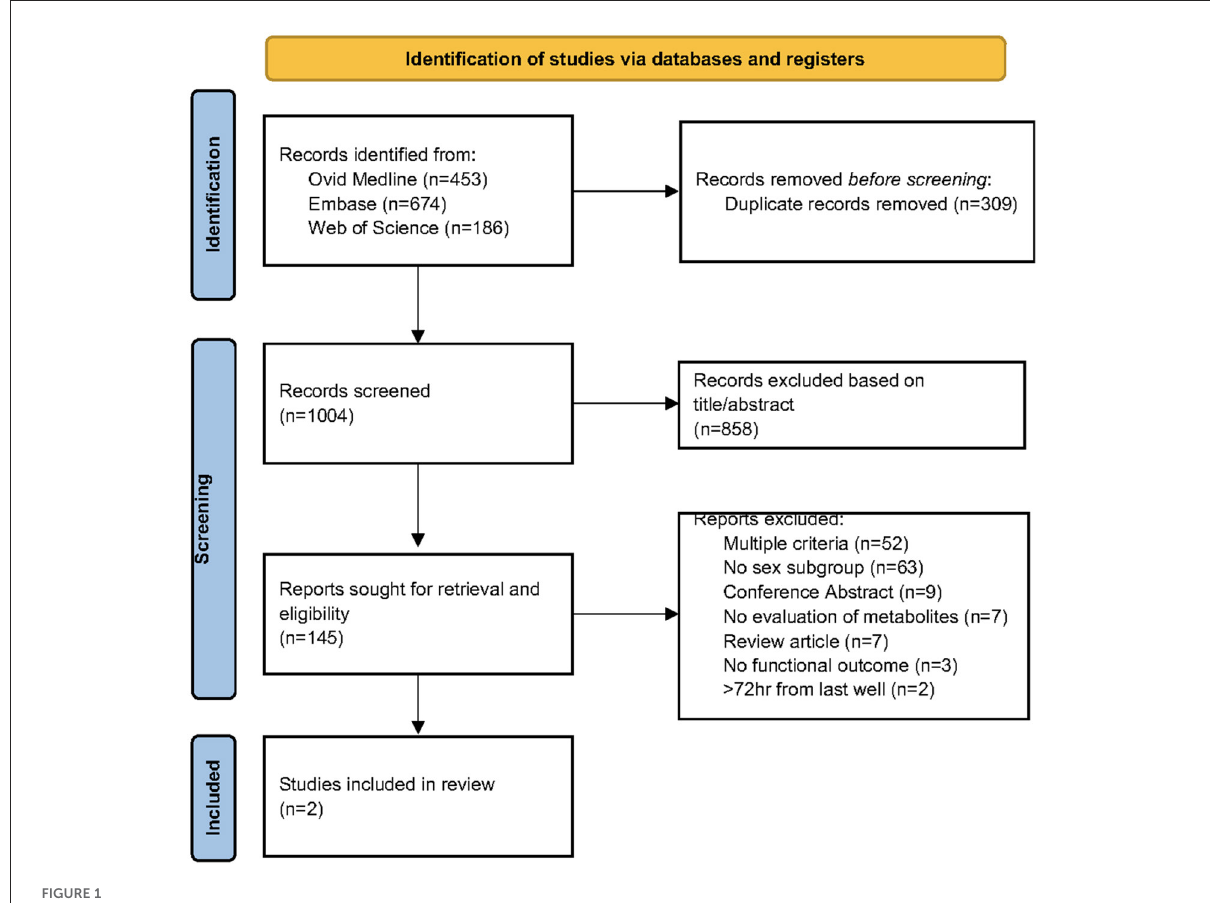
FIGURE1 PRISMA diagram.